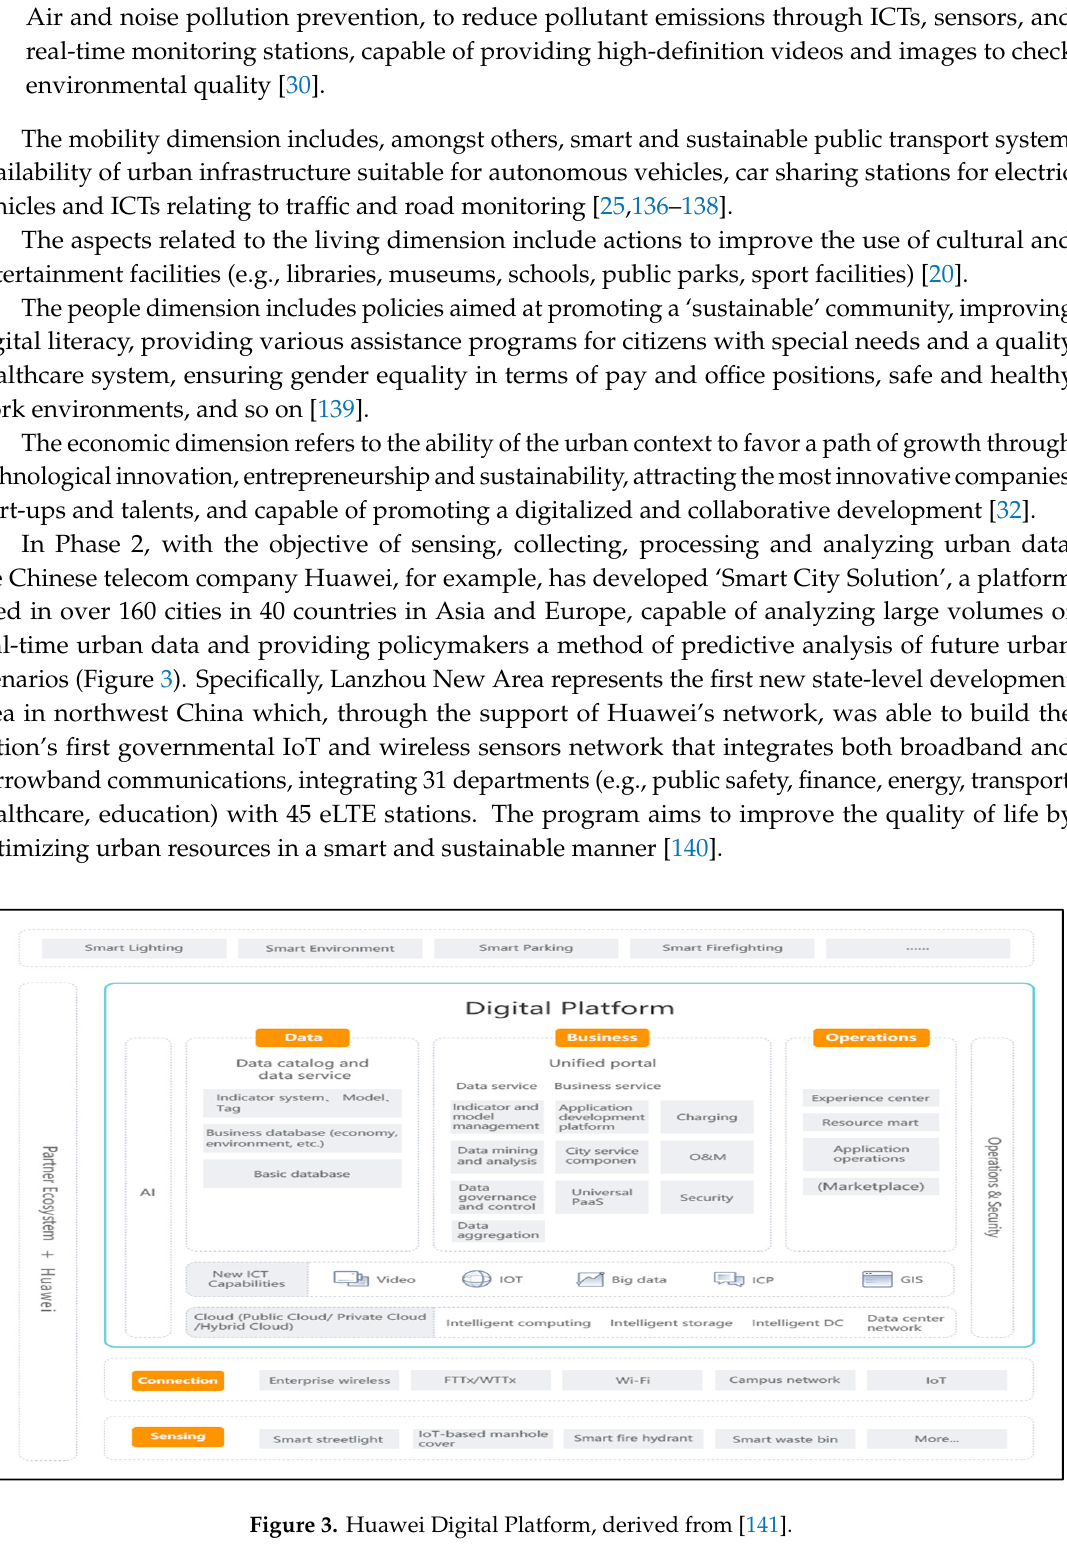
Figure 4. The Cisco Smart + Connected Digital Platform, derived from [143]. At the same time, Alibaba has developed the ‘City Brain’ program that has also become a useful tool for city managers, providing a holistic dashboard that can improve the perception of urban data and real-time processing capacity [144]. Figure 5 shows the real-time detection and analysis platform for city events. By integrating the data from the surveillance rooms, it is possible to coordinate traffic lights to give priority passage to response vehicles (e.g., police, fire-fighters, rescue and other vehicles) in case of emergency. Likewise, the program has been launched in several Chinese cities such as Hangzhou, Shanghai, Chongqing, Suzhou, Haikou, Beijing, Chengdu, Quzhou, and Jiaxing. Projects as CityBrain highlight the continuous interaction between local